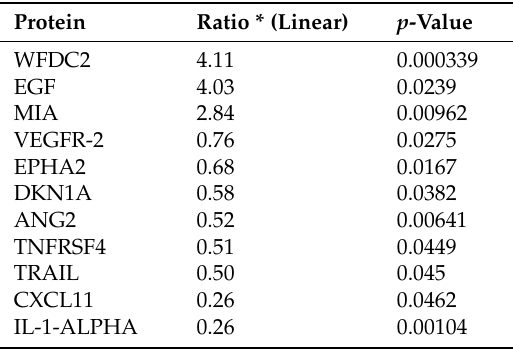
Table 5. Proteins related to recurrence in HPV negative TSCC and